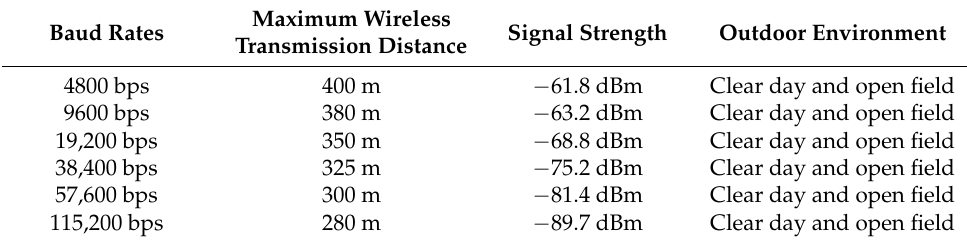
Table 6. The wireless transmission performance test of the IA.